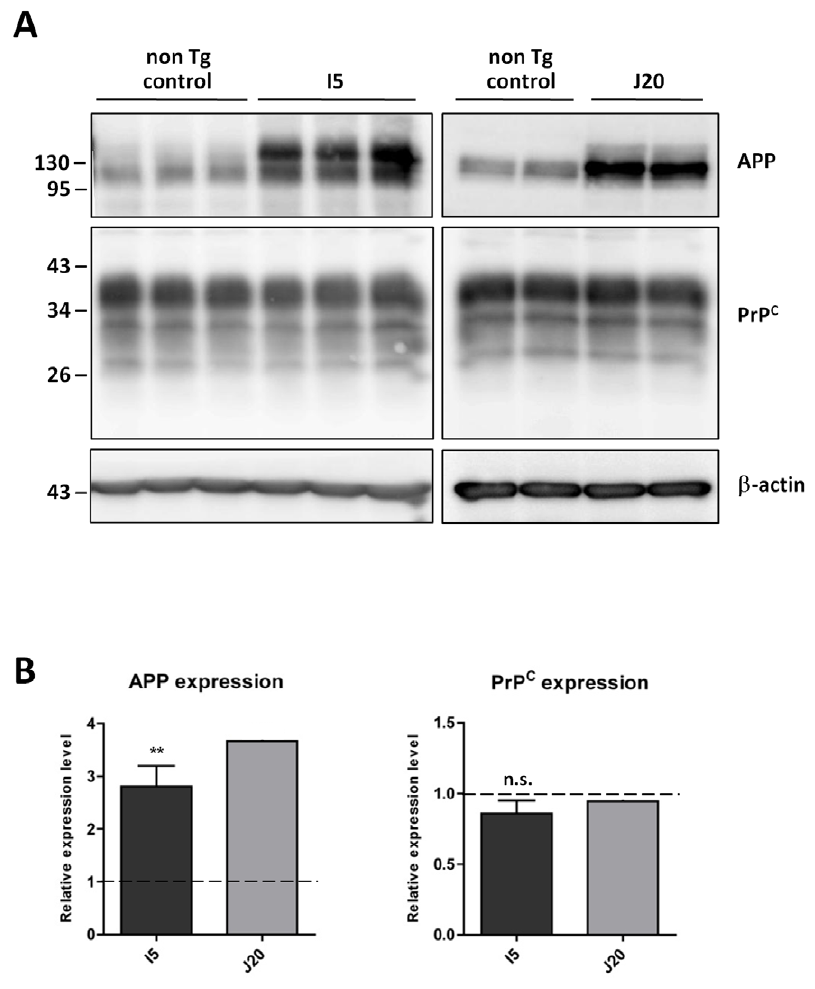
Figure 3. Unaltered PrP C protein levels in transgenic mice over-expressing human wild type or familial AD mutant APP. (A) Western blot of APP and PrP C (antibody 6D11) in I5 (n=3) and J20 (n=2) transgenic, and age-matched non-transgenic control, mouse brain homogenates, with membrane re-probing for b -actin. Approximate molecular weights (kDa) are indicated. (B) Quantification of APP and PrP C protein levels expressed relative to the control mice (dashed line). Error bars represent 6 SD. Statistical analysis by unpaired t-test, **p , 0.01, n.s. not significant.